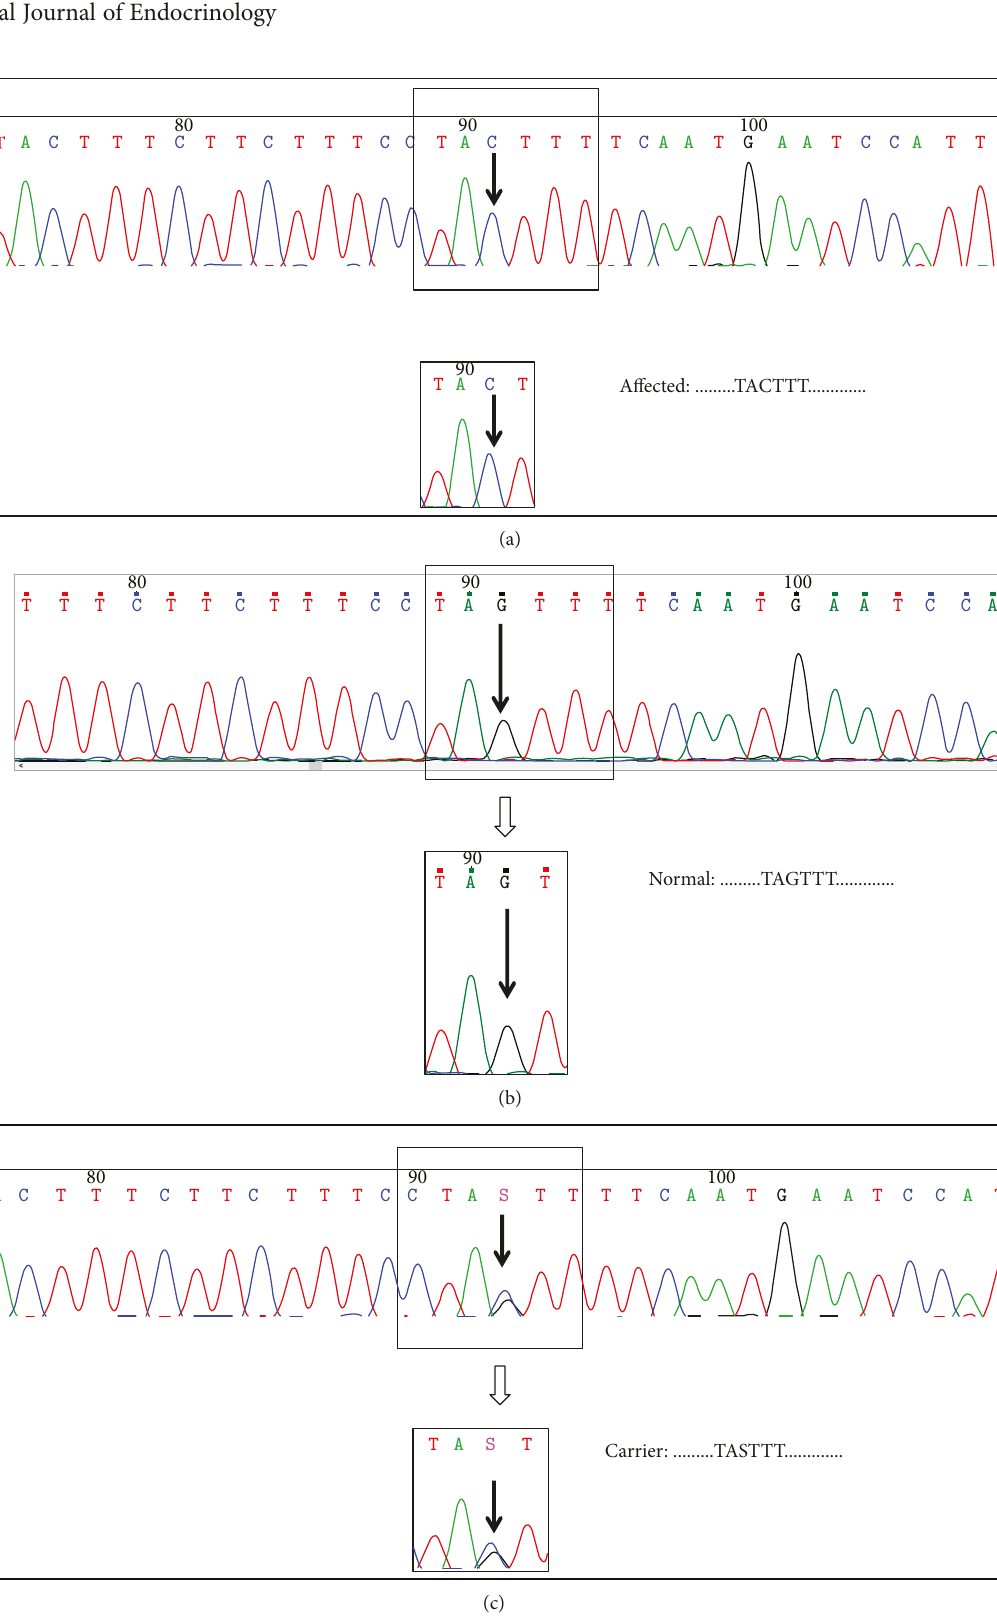
Figure 3: Sequencing results of the SEDL gene. As shown in the diagram, panels (a), (b), and (c) represent the patient sequence, the normal sequence, and the carrier sequence, respectively. The location of the arrow is the mutation site reported in the study. (a) Patient sequence (hemizygote), a missense mutation occurred in the patient ’ s gene, G to C. (b) Normal sequence, the normal base in the gene at the sequenced site is C. (c) Carrier sequence (heterozygote). The mutation in female carriers is S